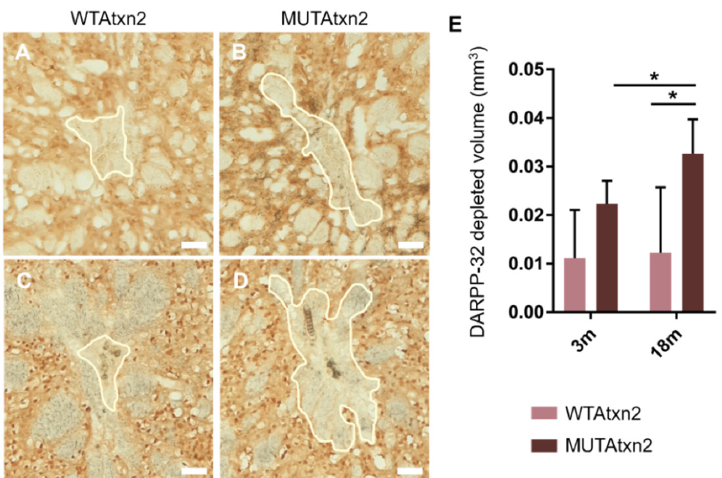
Figure 2. The hemisphere injected with MUTAtxn2 displayed a significantly higher volume of neuronal marker loss, compared to the hemisphere injected with WTAtxn2. ( A – D ) Representative immunohistochemistry of striatal sections stained with the DARPP-32 marker. Regions contained inside the white line have a depleted DARPP-32 signal. Scale bar: 50 µm. ( E ) Quantitative analysis of the DARPP-32 marker depleted volume in 3-month-old ( n = 6) and 18-month-old ( n = 3) animal groups. Values are expressed ± SEM (standard error of the mean) (one-way ANOVA, * p < 0.05).